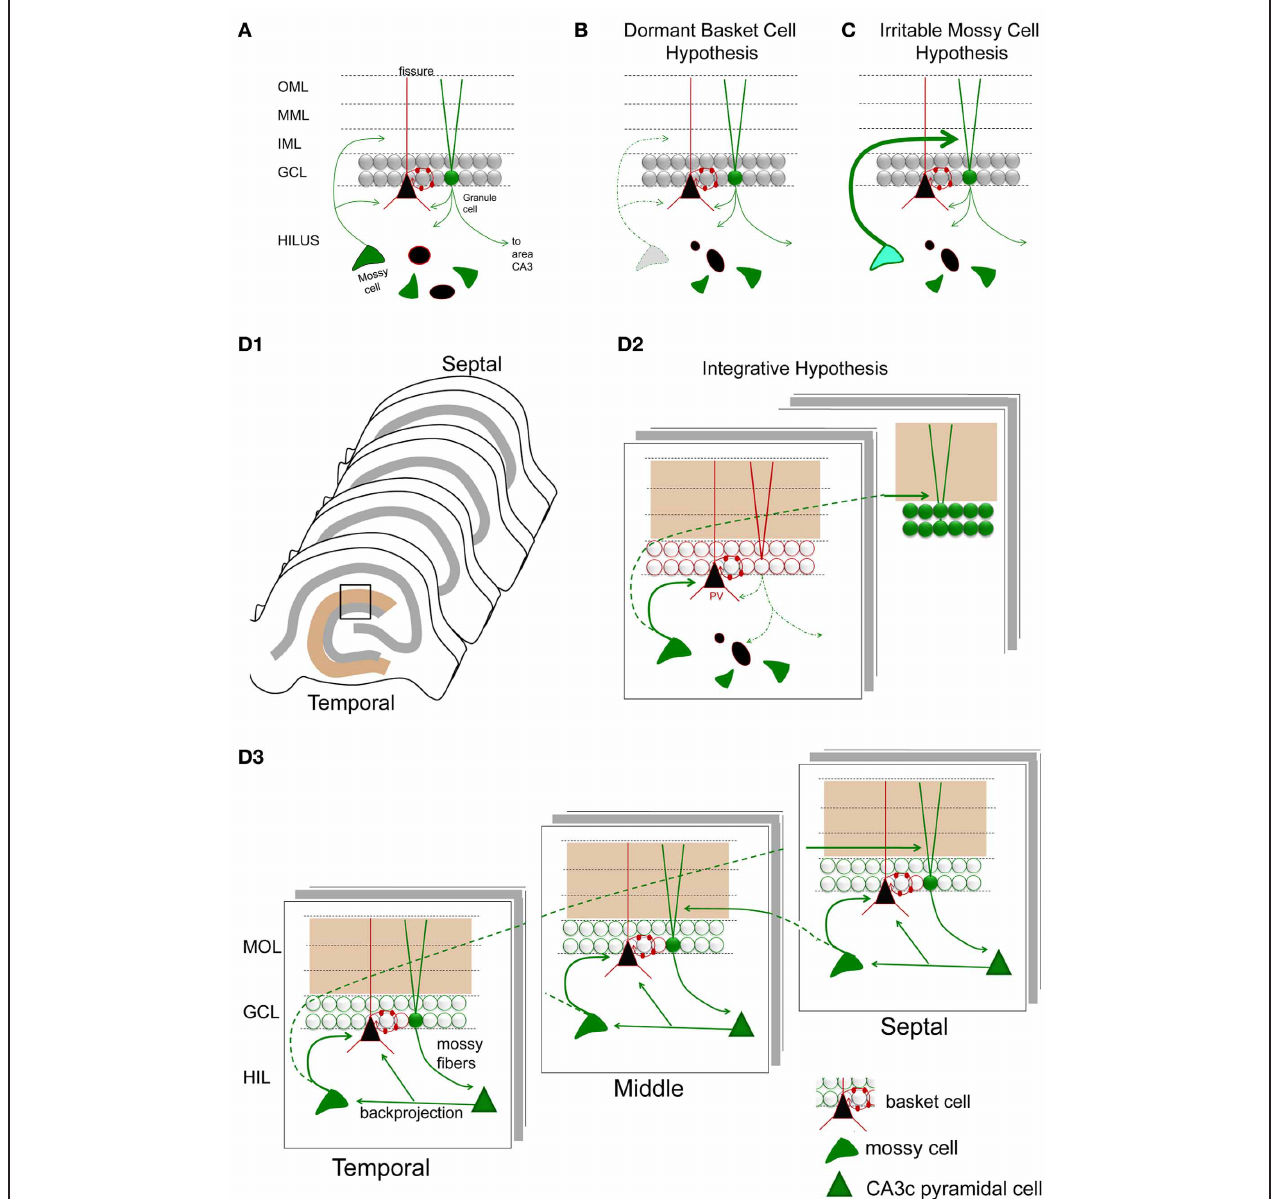
FIGURE 8 | Hypotheses for mossy cell vulnerability and function. (A) An illustration of the circuit components used in parts (B–D) . Only some cell types in the DG are shown. Green cells and fibers represent glutamatergic cells and their axons; black cells and their red processes represent GABAergic neurons and their dendrites/axons. The triangular black cell represents the prototype of the GABAergic neuron, the basket cell. (B) The dormant basket cell hypothesis is illustrated schematically. Without mossy cell afferent input, basket cells do not have sufficient afferent input to inhibit granule cells. The result is disinhibition of granule cells. (C) The irritable mossy cell hypothesis is illustrated schematically. When mossy cells are activated, they directly excite granule cells. After traumatic brain injury, they discharge more. The net effect is more granule cell excitation. (D1) A representation of the lamellae of the hippocampus is shown. Brown = molecular layer. Gray = cell layers. (D2) A hypothesis that incorporates aspects of the dormant basket cell and irritable mossy cell hypotheses. (a) Mossy cell axons near their cell body, i.e., within the lamella of the mossy cell soma, innervate GABAergic neurons primarily, leading to inhibition of